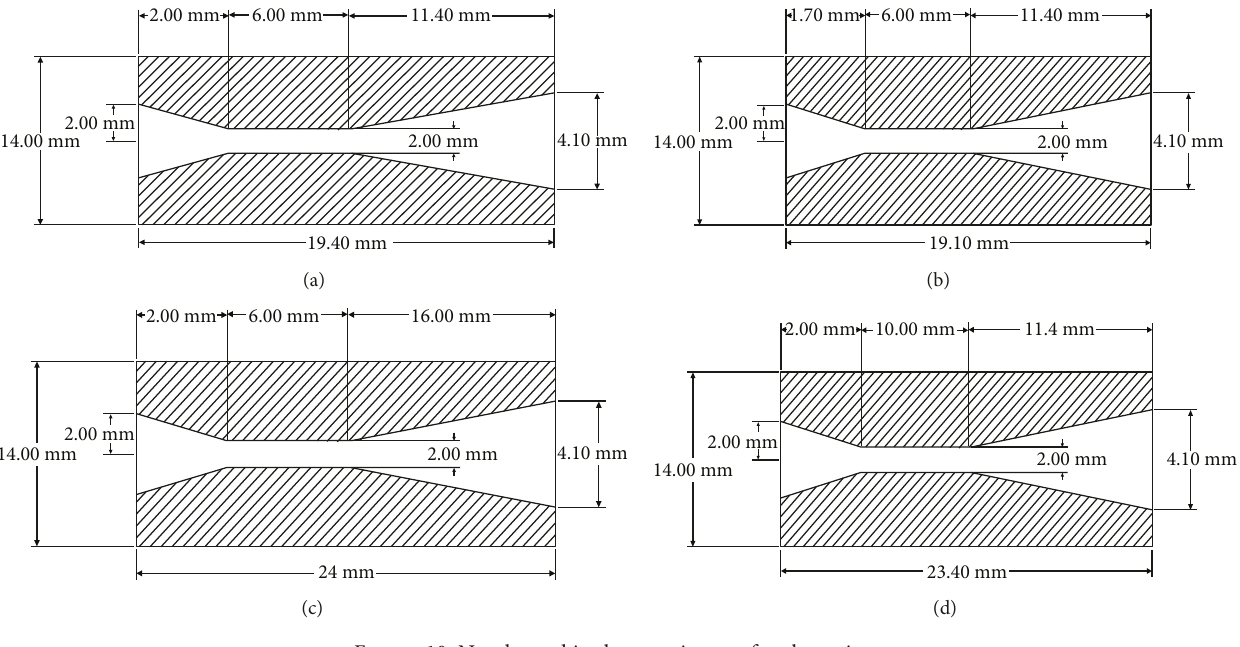
Figure 10: Nozzle used in the experiment of rock erosion.